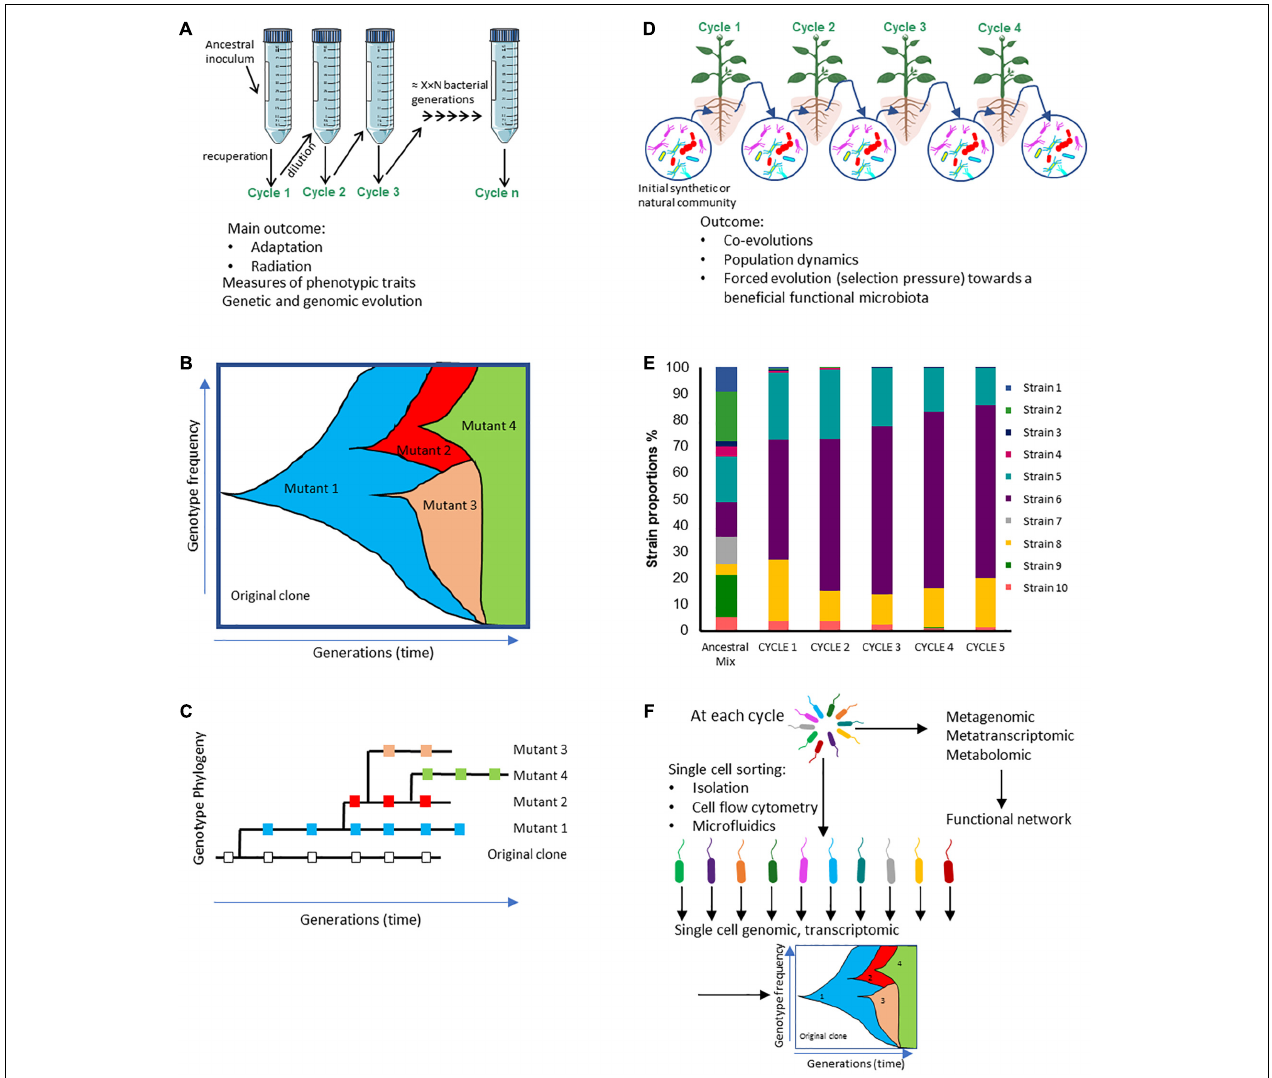
FIGURE 1 | Comparison of the potential outcomes from experimental evolution (EE) studies starting with (A) a single clone or (D) a microbial community. (A) Example of an experimental evolutionary design based on a single clone serially cultivated in a simple medium, a stressful or a changing environment; those experiments enable to track phenotypic and genetic changes over time. (B) Theoretical Muller diagram depicting the distinct genotypes frequencies over microbial generations that could be observed in EE study described in A. (C) Theoretical phylogenetic tree built from genotypes that can be sampled from different time points throughout the EE described in A and sampled at the same generation times. (D) Example of an experimental evolutionary design based on an inoculum made up of several microorganisms (synthetic or natural communities); those experiments make it possible to monitor changes in population levels (E) , and genetic, transcriptomic or metabolomic changes over time (F) . (E) Theoretical bar graph illustrating the composition of a microbial community showing differences in taxa among both the inoculum (ancestral mix) and different experimental cycles. (F) At each cycle, approaches could be implemented at the scale of the whole community (i.e., meta-omics) or of individual cells after cell-sorting (single-cell sequencing,